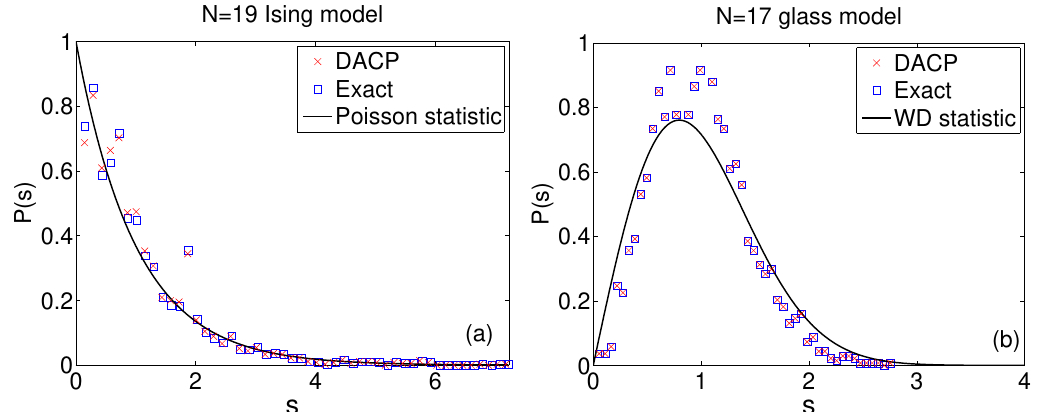
Figure 4: Statistical distributions of the level spacings s , for (a) Ising model with N = 19 and (b) spin glass shards model with N = 18. The probability distributions P ( s ) come from the numerical results of DACP (red circles), the exact eigenvalues (blue squares), Poisson statistic P ( s ) = exp ( − s ) (black curve in (a)) and Wigner- Dyson GOE statistic (black curve in (b)). The horizontal axis s is in units of mean level